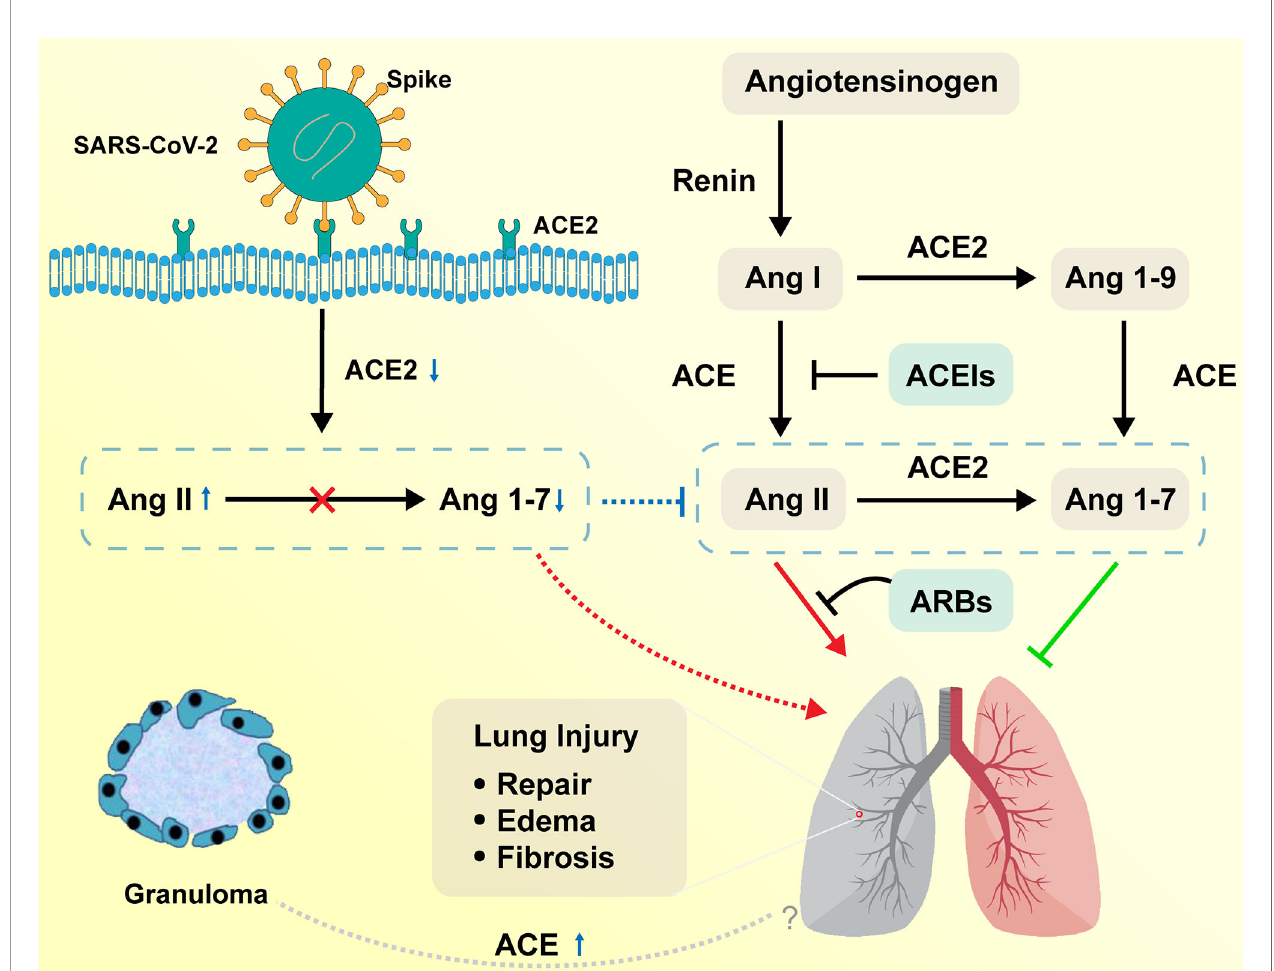
FIGURE 2 | Function of RAS in the respiratory system on COVID-19 and sarcoidosis. Angiotensinogen is converted by renin to Ang I. Ang I is subsequently converted to Ang II by ACE, which is expressed on the surface of endothelial cells in the lung and kidney. Ang II in the pulmonary system promotes tissue repair and fi brosis, while it can also promote the occurrence of pulmonary edema and impair lung function. ACE2 negatively regulates the function of ACE by converting Ang I to Ang 1 – 9 and Ang II to Ang 1 – 7. ACEIs inhibit the production of Ang II and ARBs inhibit the binding of Ang II to angiotensin receptors. SARS-CoV-2 interacts with ACE2 and infects ACE2-expressing epithelial and endothelial cells in the lung and other organs, leading to the downregulation of ACE2. The downregulation of ACE2 leads to unopposed Ang II accumulation, which may accelerate the progress of COVID-19 via increased activity of RAS. Sarcoidosis granuloma epithelioid cells may be engaged in ACE biosynthesis, resulting in the elevation of serum ACE levels. The relationship between elevated ACE and sarcoidosis remains to be explored. RAS, renin – angiotensin system; ACE, angiotensin-converting enzyme; Ang I, angiotensin I; ACEIs, angiotensin-converting enzyme inhibitors; ARBs, angiotensin receptor